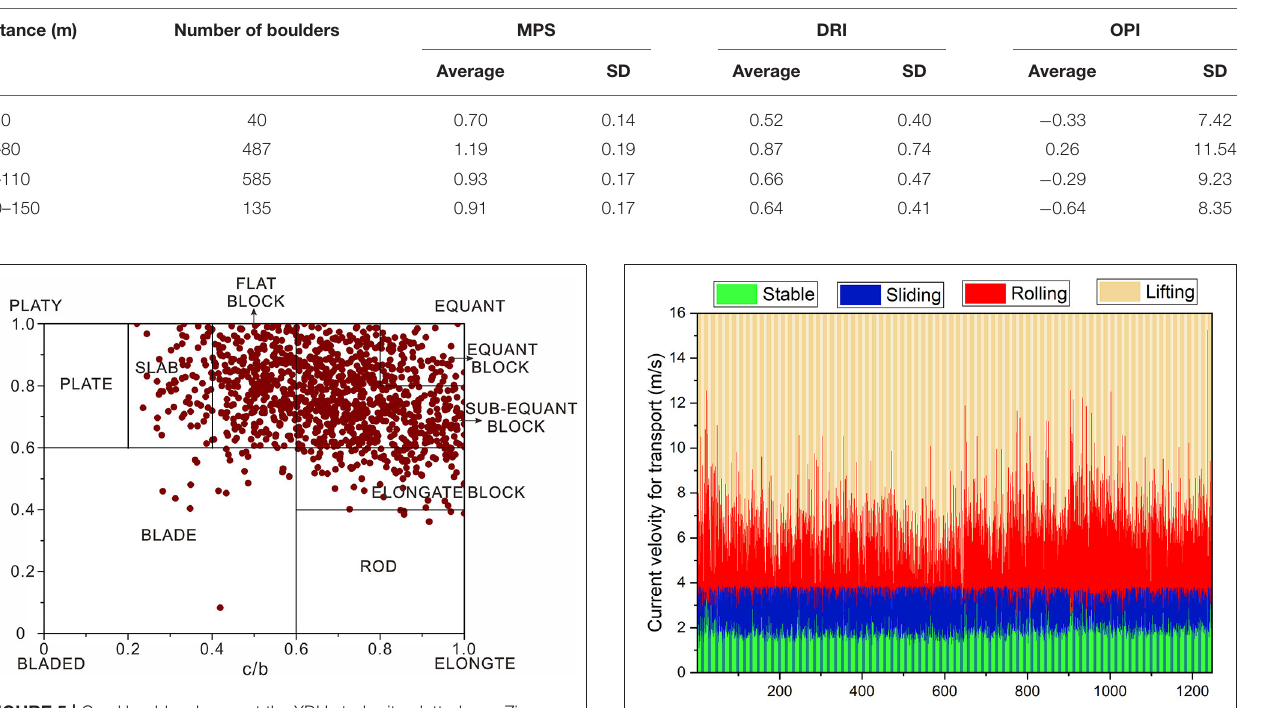
FIGURE 5 | Coral boulder shapes at the XDH study site plotted on a Zingg diagram ( Zingg, 1935; Blott and Pye, 2010; Terry et al., 2015).